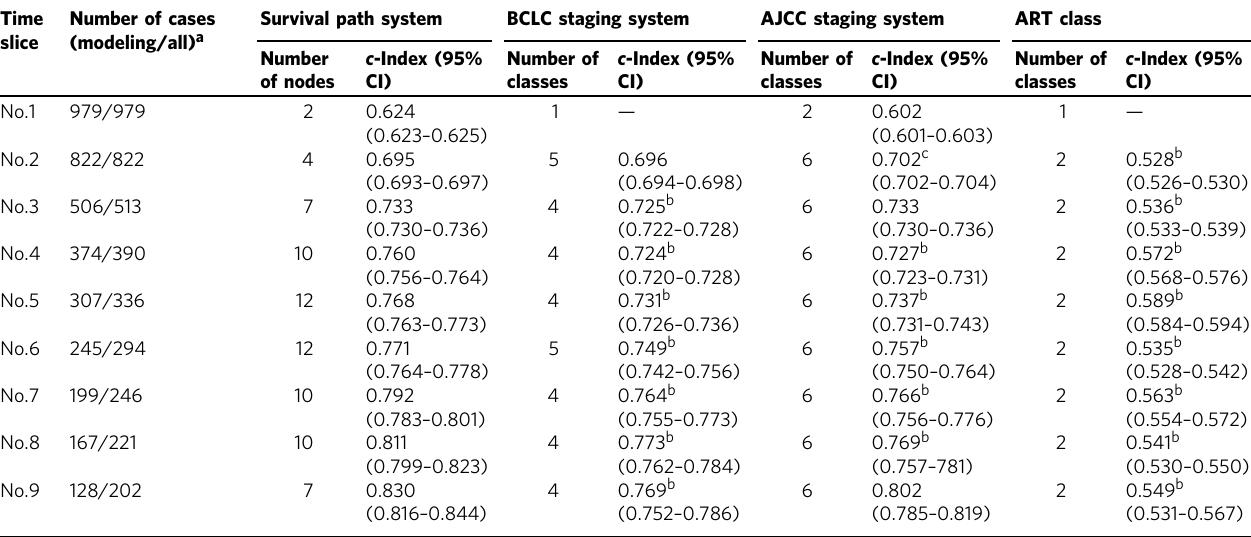
Table 2 Comparison of c -index between the survival path system, BCLC staging system, AJCC staging system, and ART score at each time slice in the derivation